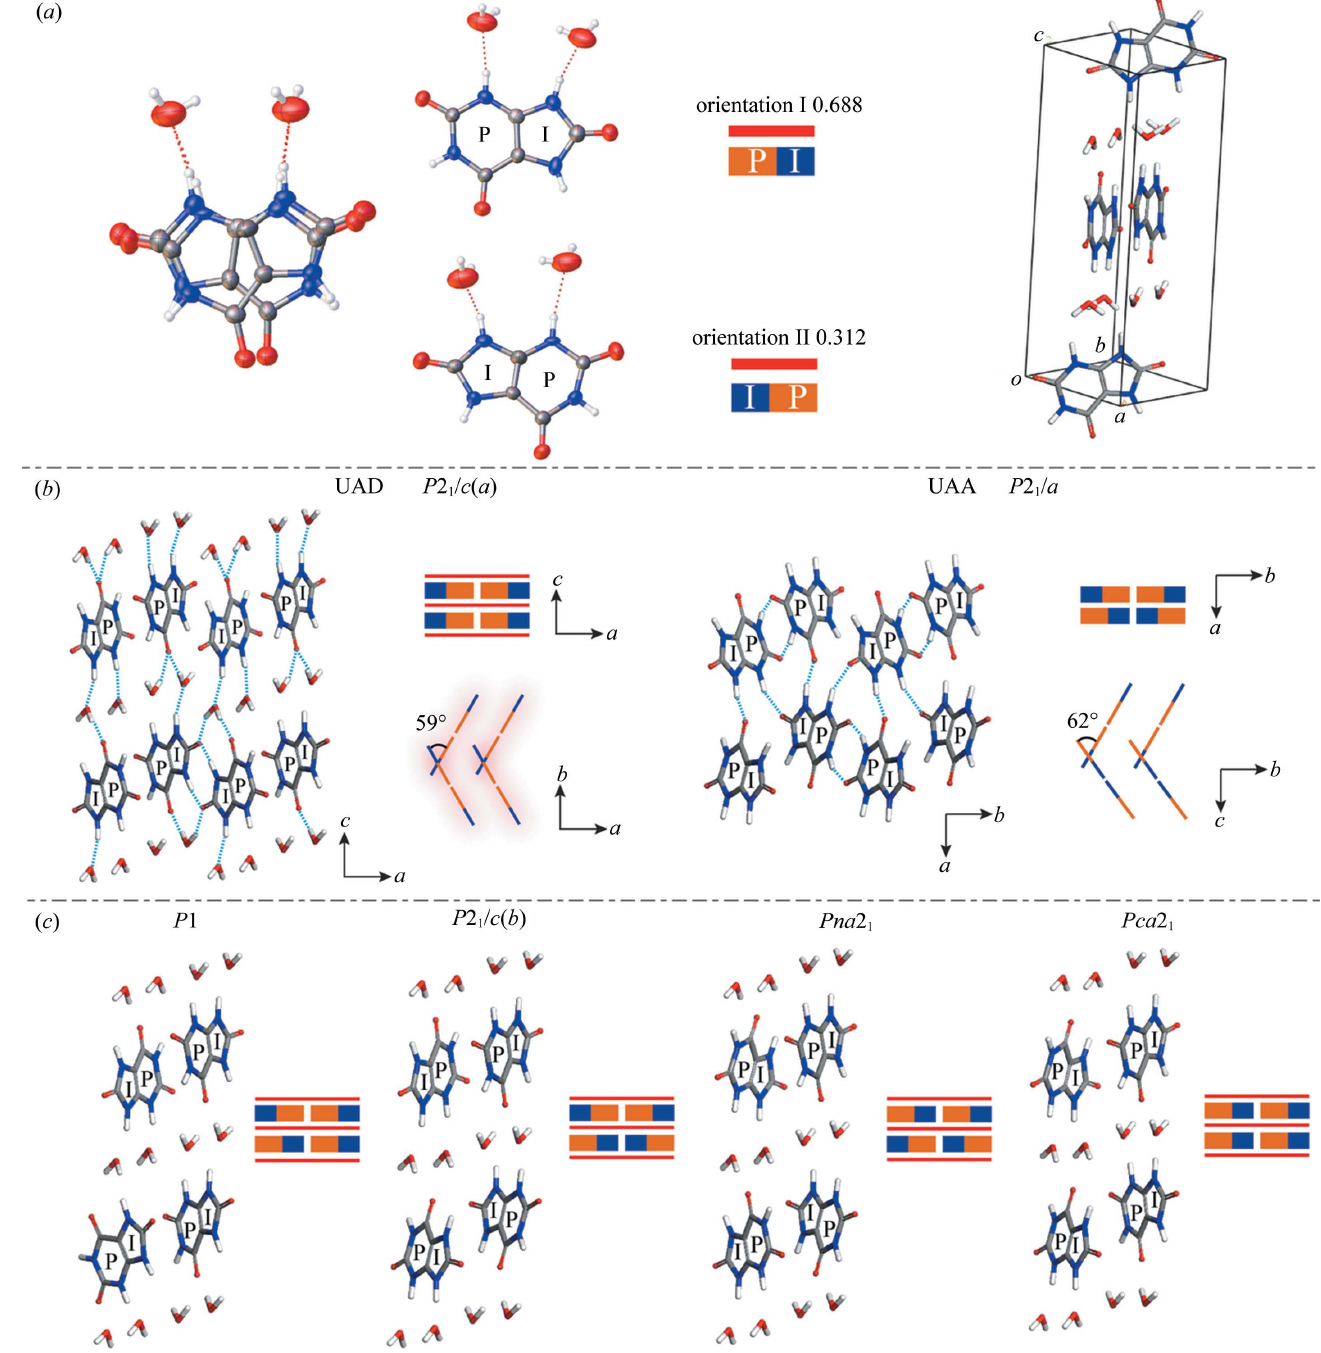
Figure 7 Orientational disorder and potential crystal-packing arrangements: ( a ) two distinct orientations (P-to-I versus I-to-P) of the UA molecule in the UAD unit cell with the chemical occupancy 0.688:0.312; ( b ) molecular packing of UAD (Parkin & Hope, 1998) and UAA (Ringertz, 1966); ( c ) molecular packing of potential disordered packing arrangements of UAD. Carbon, nitrogen, oxygen and hydrogen atoms are marked in gray, blue, red and white,